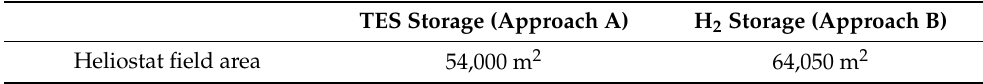
Table 2. Heliostat field sizing.